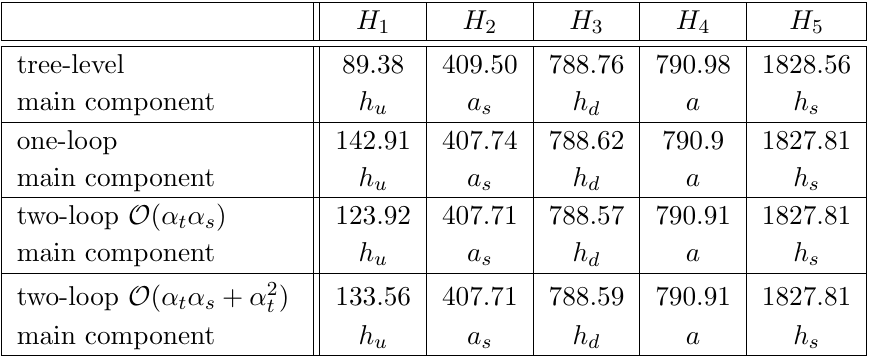
) obtained using OS renormalization t